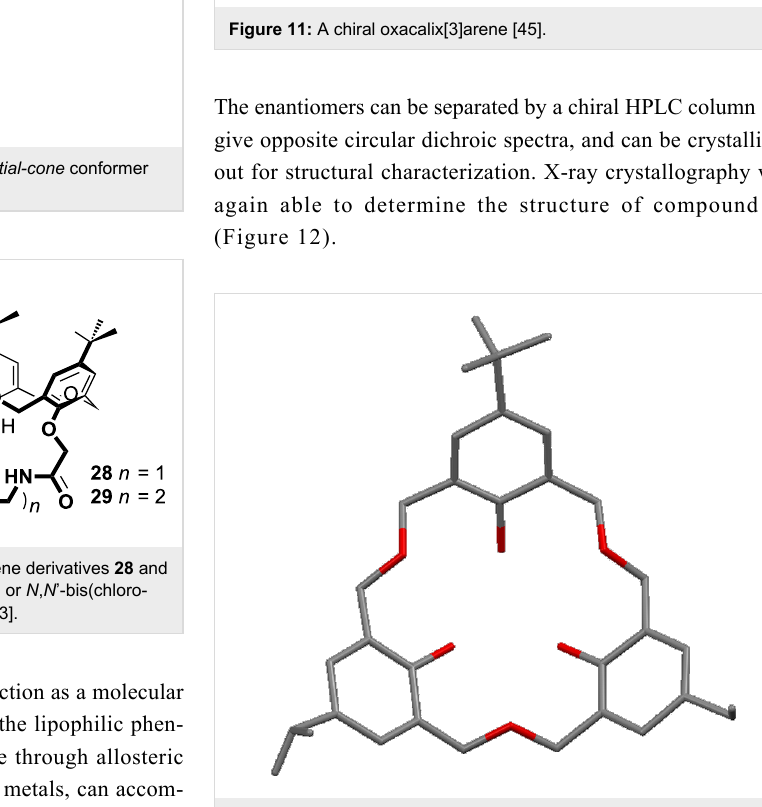
Figure 12: X-ray crystal structure of asymmetric oxacalix[3]arene 30 incorporating t -Bu, iPr and Et groups (CCDC ID 108839)